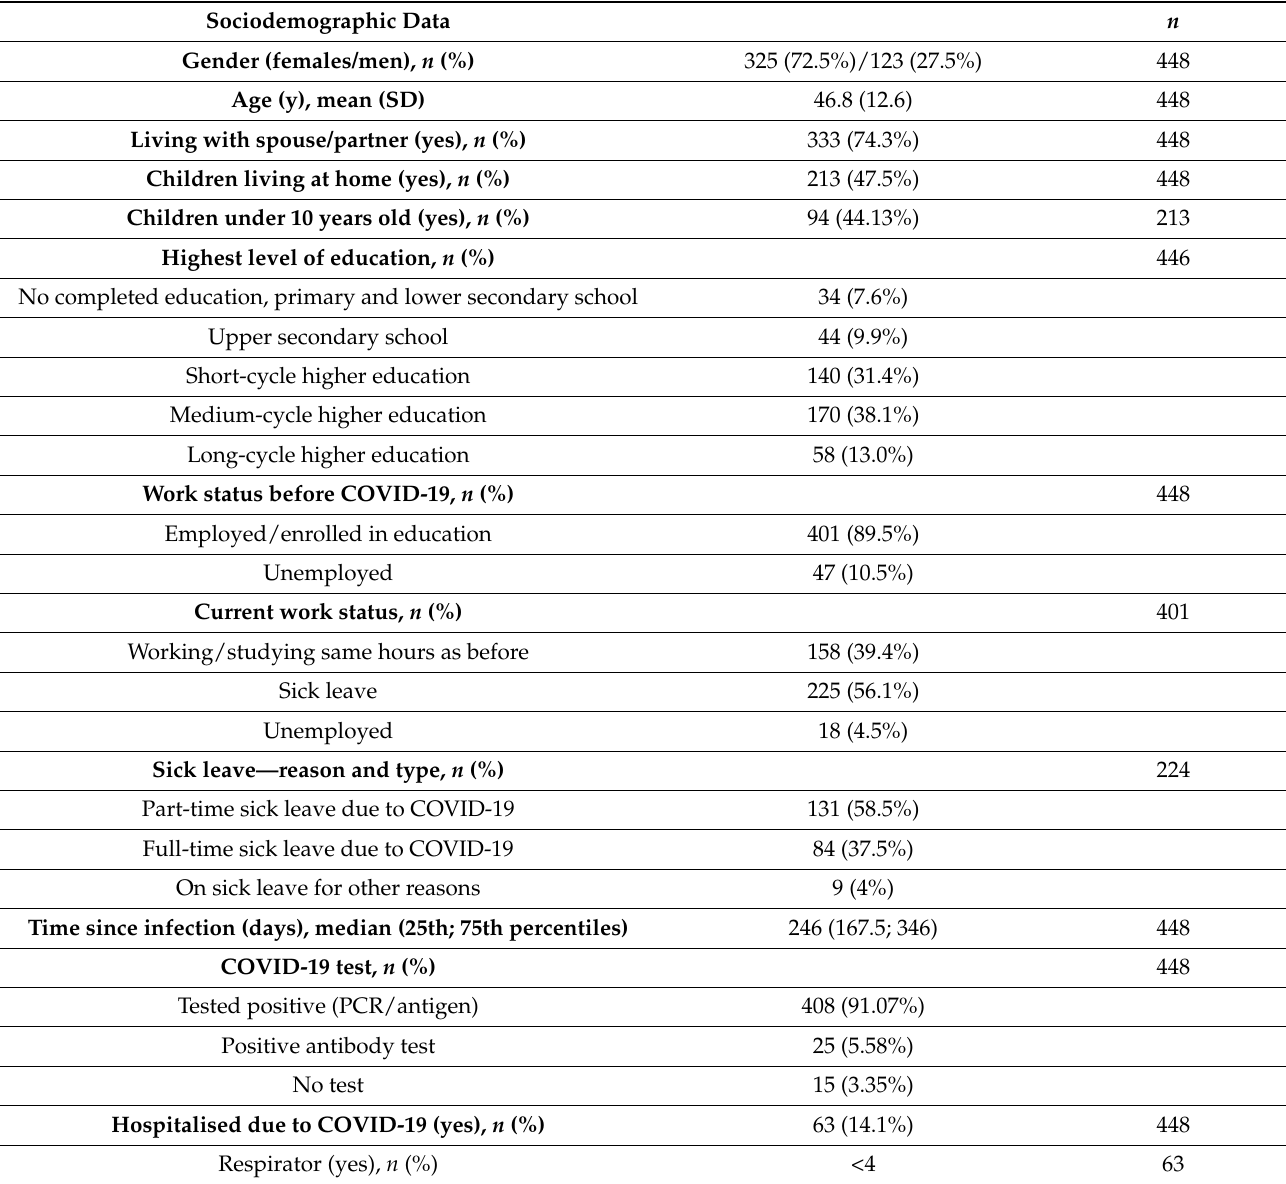
Table 1. Participant characteristics and sociodemographic